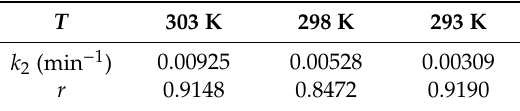
Table 3. Arrhenius plot fitting parameters.